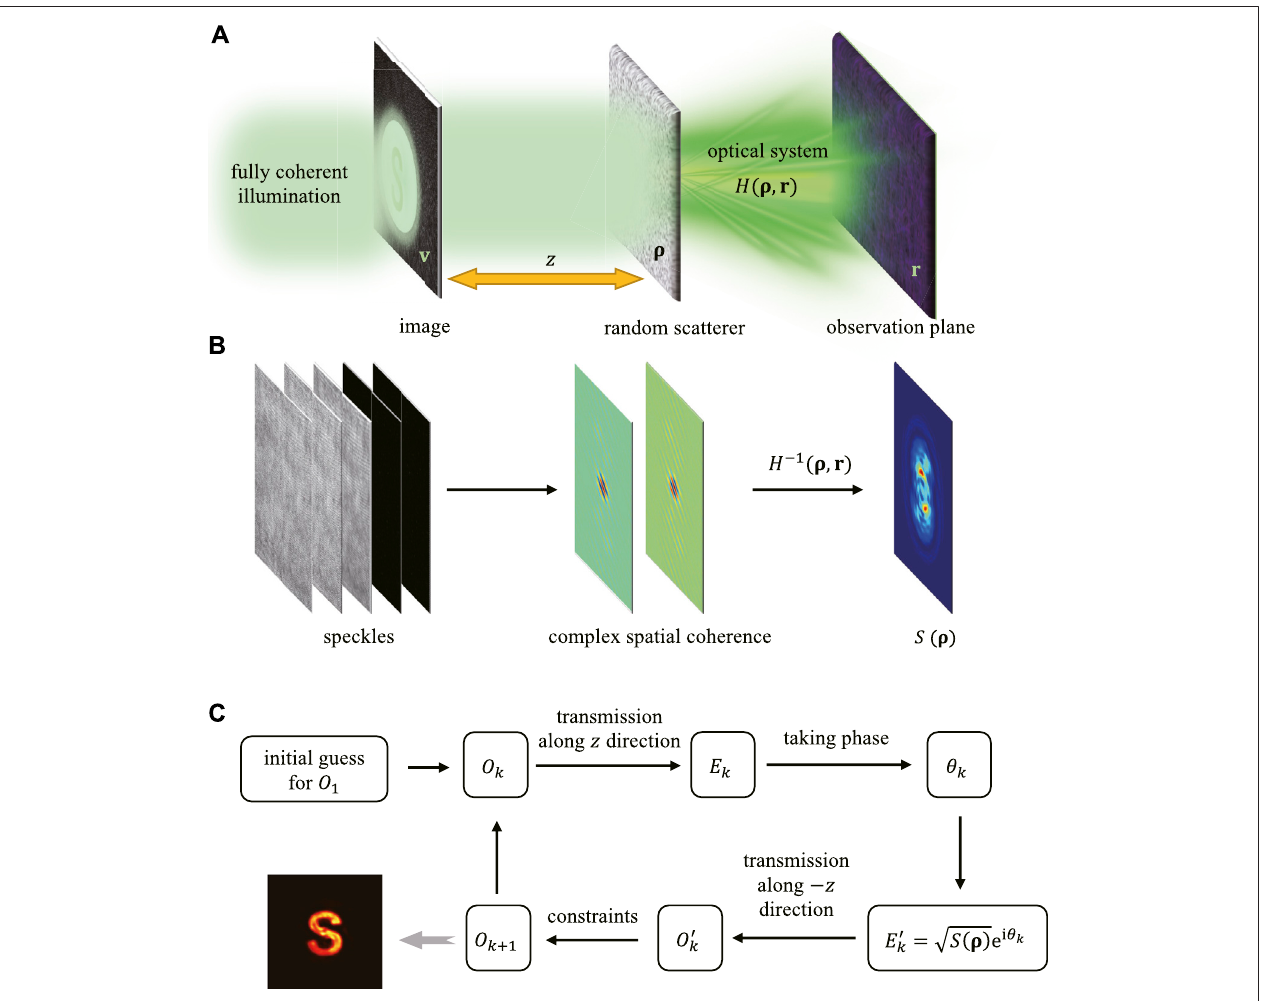
FIGURE1| Schematicdiagramofopticalimagingthrougharandomscatteringmedium. (A) Theimagehiddenadistance z behindarandomscattererisilluminated by a fully coherent light. The scattered light from the random medium passes through an optical system with response function H ( ρ , r ). The complex spatial coherence structureismeasuredintheobservation plane. (B) Theintensity S ( ρ )onthefrontsurfaceoftherandomscatterercanberecoveredthroughinversetransform H − 1 ( ρ , r )of the measured complex spatial coherence. (C) The fl owchart of the iterative phase retrieval algorithm.